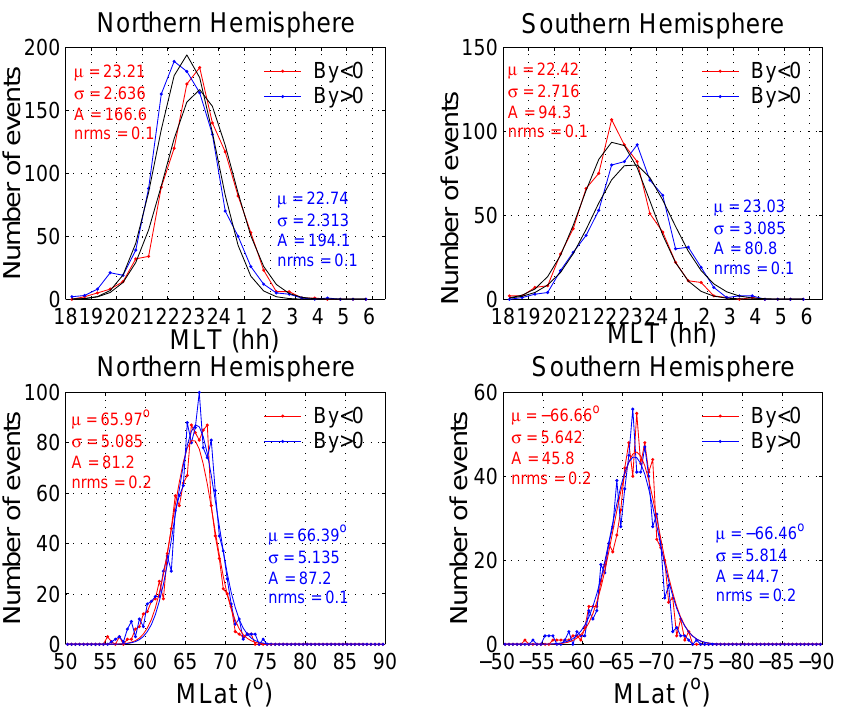
Fig. 3. Number of events of substorm onsets as a function of MLT and MLat for IMF B y > 0 and IMF B y < 0 in the Northern (left) and Southern (right)